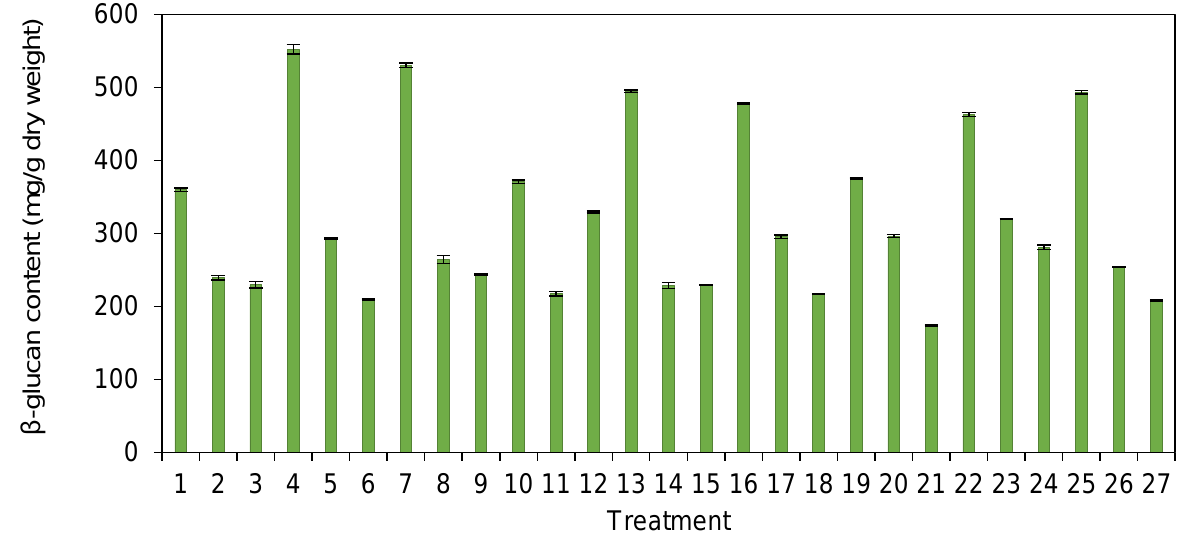
Figure 1. The contents of β-glucan in the H. erinaceus extracts from different pretreatment processes (Error bars represent a standard deviation of three replicates).